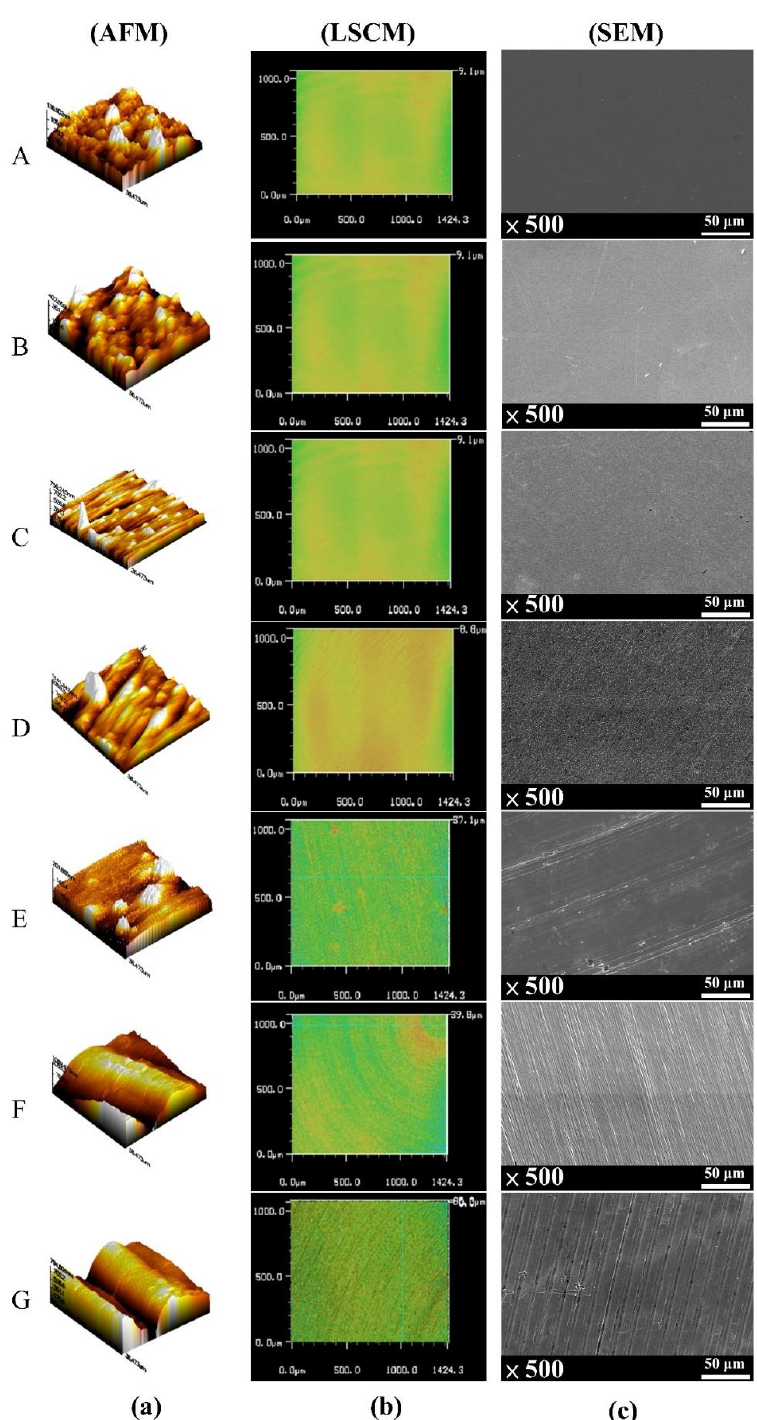
Figure 3. ( a ) AFM micrographs, ( b ) LSCM micrographs, and ( c ) SEM micrographs of Specimen A–G. AFM micrographs is showing that surface roughness of specimen A–G are changed from low to high. LSCM micrographs is revealing macro surface roughness of specimen A–G. The SEM image of is indicates specimen A–C show smooth surface and specimen D–G show directional scratches.